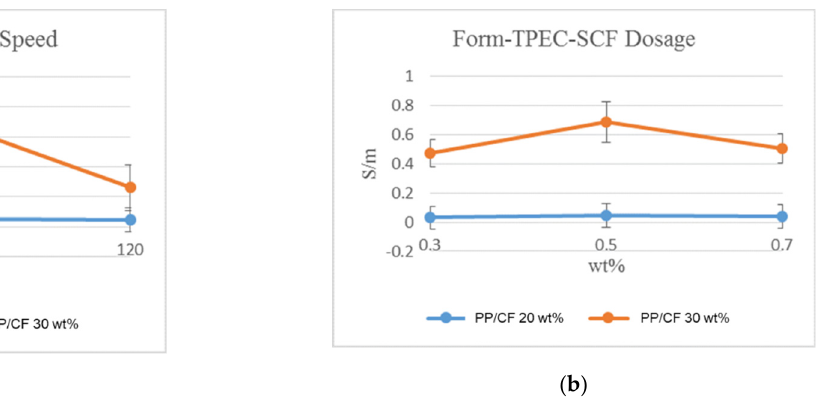
Figure 7. Values of TPEC after SCF foaming under various injection speeds, SCF dosage, and CF content. ( a ) Different injection speeds and ( b ) different SCF dosage.